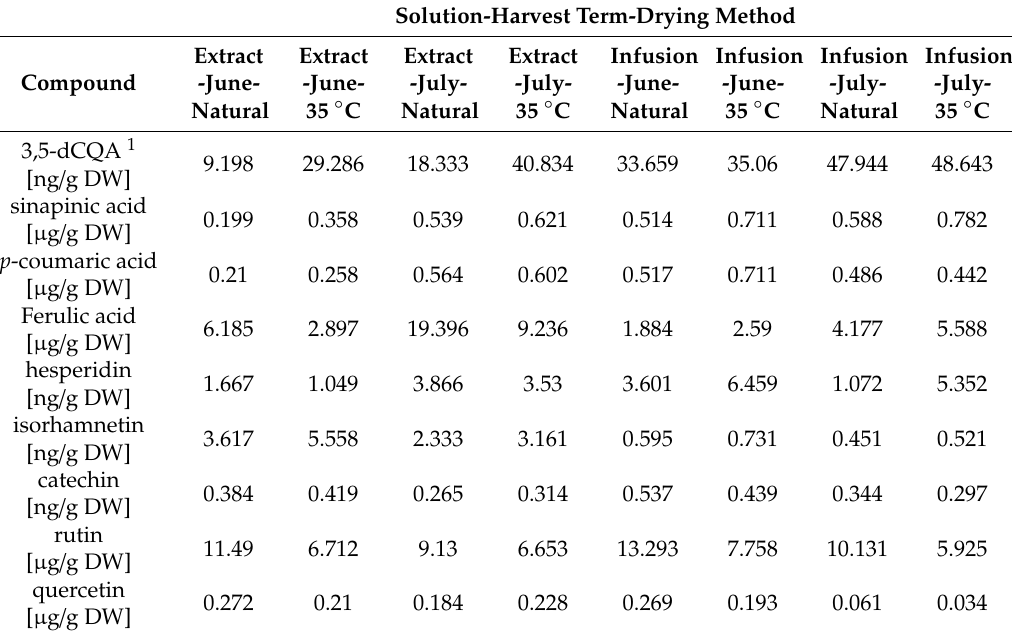
Table 5. E ff ect of harvest period and drying method on content of phenolic compounds in salvia